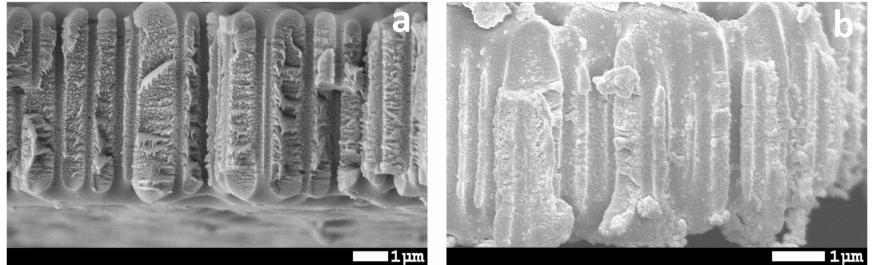
Figure 9. SEM images of cross-sectional view of initial ( a ) and modified ( b ) PET ion-track